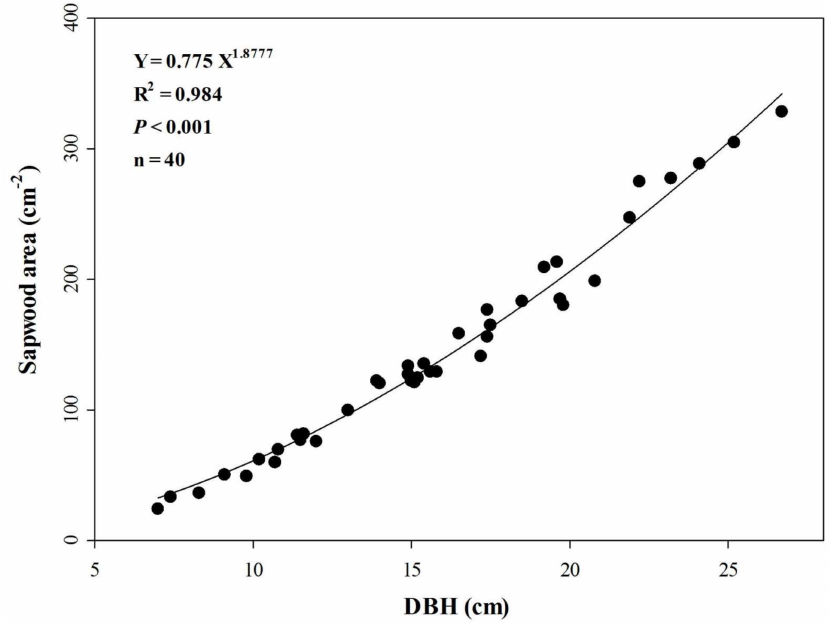
Figure 3. Relationship between sapwood area ( A s ) and tree diameter at breast height (DBH) for Chinese fir